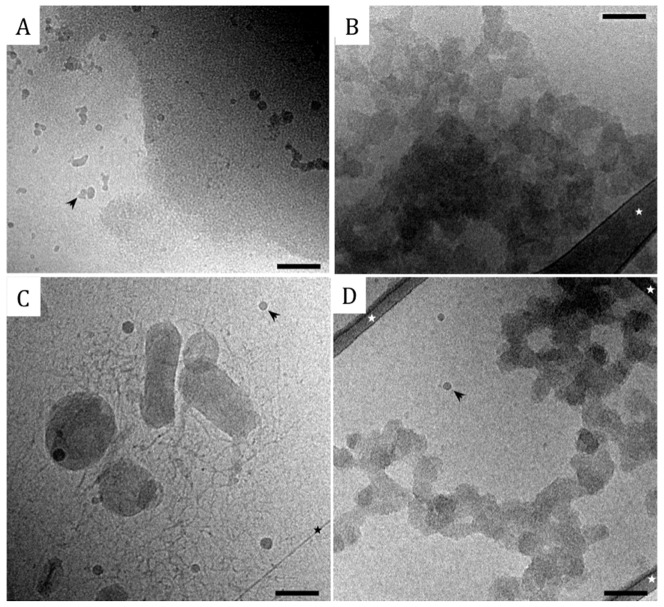
Cryo-TEM images of DNA (0.1 mg mL−1) complexes.(A, C) G4/DNA of r
charge  = 0.5, and (B, D) CTAB/DNA of r
charge  = 7.5. All samples were prepared in aqueous solutions of 10 mM NaBr, but (A) and (B) display G4/DNA and CTAB/DNA complexes, respectively, after being transferred to the tRB used for in vitro transcription/translation experiments. (C) and (D) are the reference samples in the 10 mM NaBr solution used for DNA compaction. Scale bars are 100 nm, the arrow indicates frost (artifact), the white stars indicate the carbon film and the black star shows a fracture of the vitreous film.